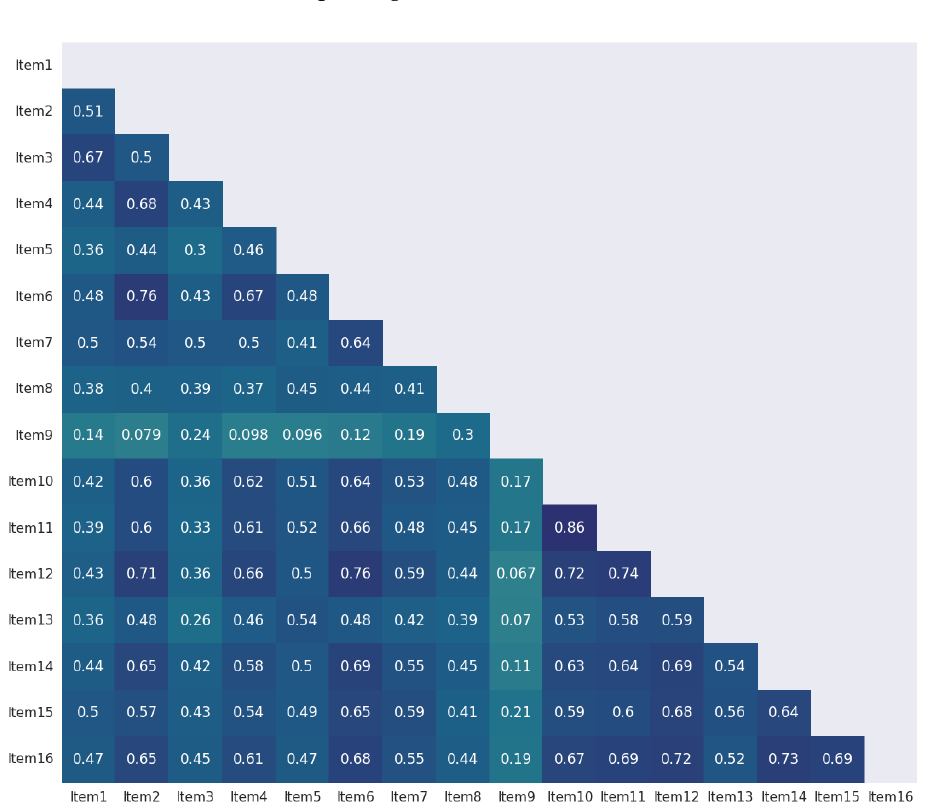
Figure 3. A heatmap showing Pearson correlations between DSES items in Sample 2. Presented in Table 2, the results of CFA for the models tested in the study show that the two-factor models built according to Kalkstein and Tower (2009) and the Schuurmans- Stekhoven (2013) factor solutions do not meet the criteria for a good data fit for the results obtained in the study conducted in the Christian